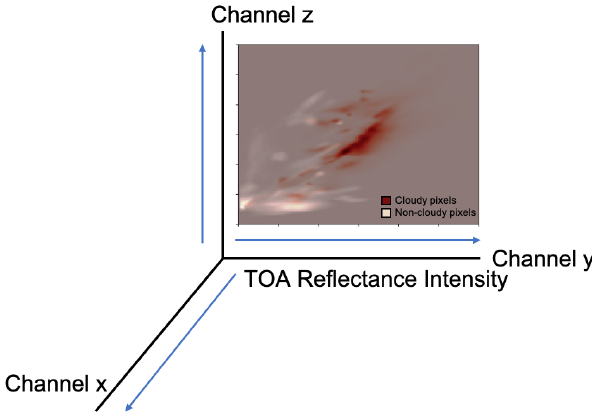
Figure 2. A schematic of the three-dimensional cloud and non- cloud brightness distributions, with an example of a marginal distri- bution in one